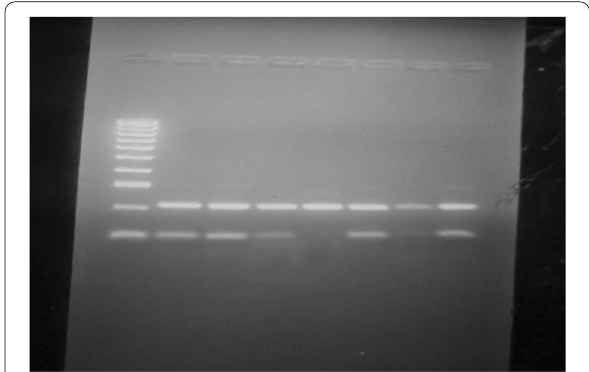
Fig. 2 Distribution of in IL2RA rs11594656 genotypes in diabetic patients and controls. Genotyping of IL2RA rs11594656 genotypes from left: • Lane 1: DNA ladder 100bp. Band (T) at (312) bp Band (A) two fragments at (211) bp and (101) bp • All Lanes showing: Homozygous (AA genotype) only (A) band present as two fragments at 211bp and 101 bp